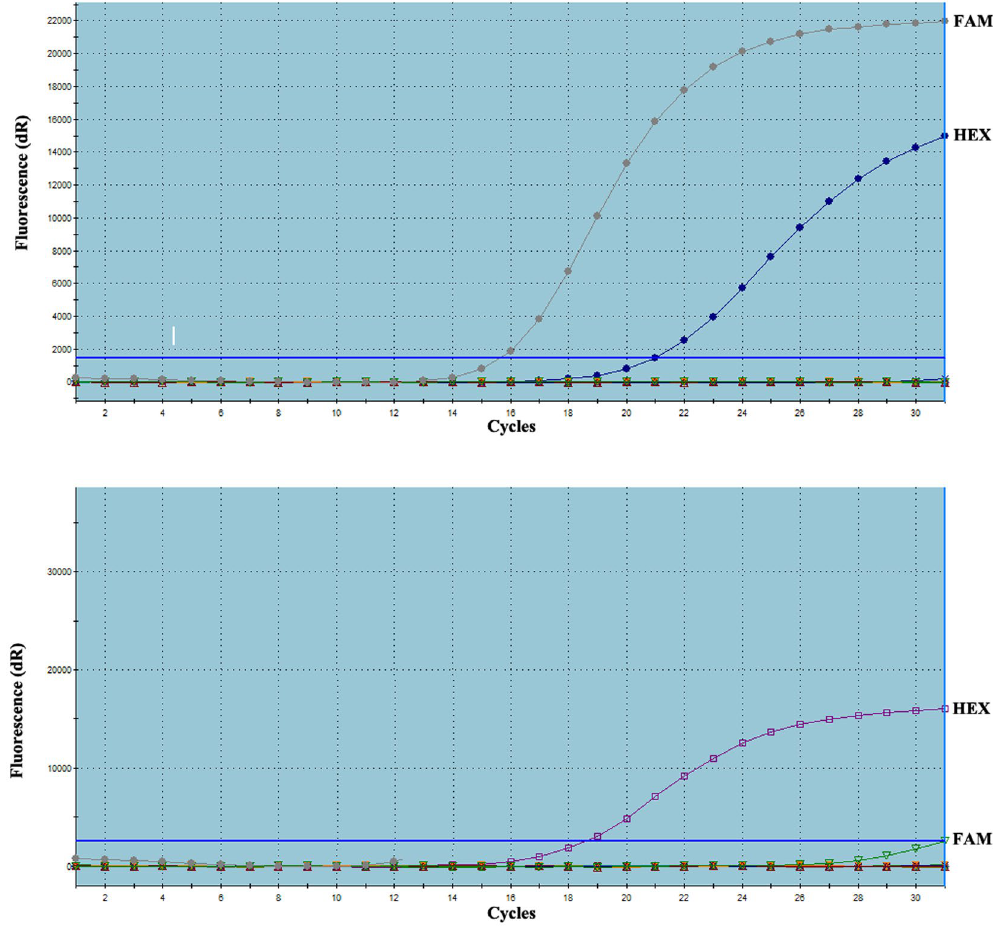
Figure 3. Graphic representations of gene mutation detection of KRAS (A, FAM( + )HEX( + ), mutant type) and